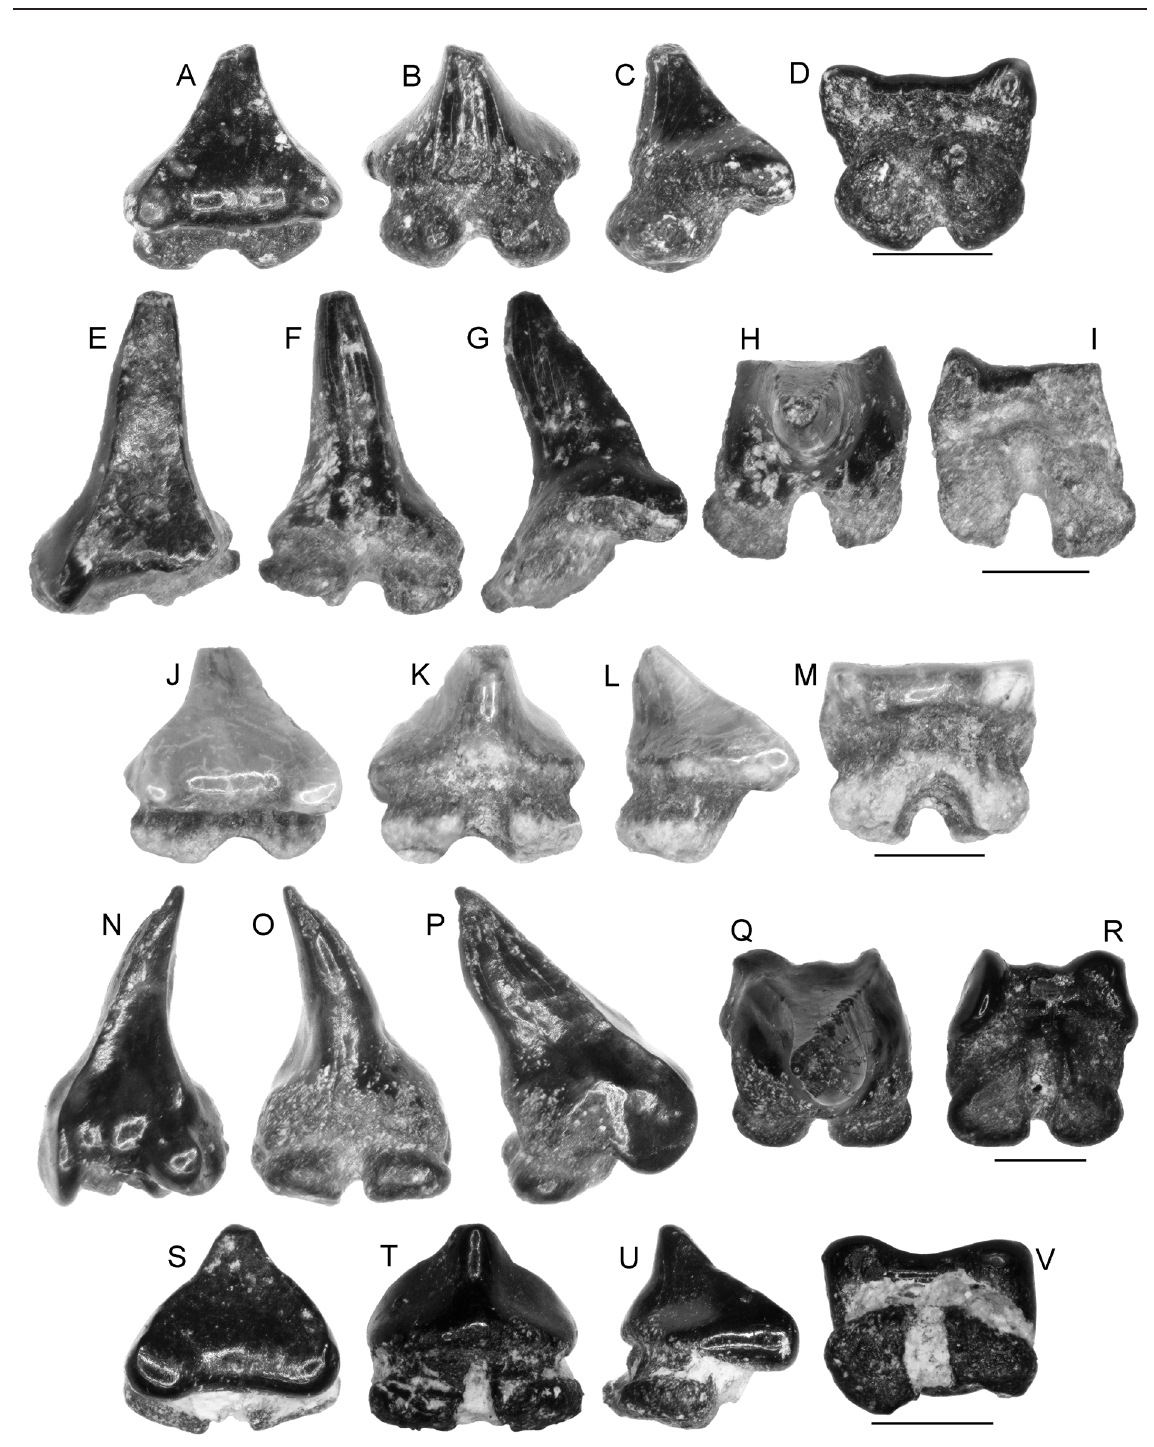
Fig. 43. Jacquhermania duponti (Winkler, 1876), teeth. A–D . SC2012.47.5, basal Lisbon Formation. A . Labial view. B . Lingual view. C . Mesial view. D . Basal view. E–I . MSC 38484, basal Lisbon Formation. E . Labial view. F . Lingual view. G . Mesial view. H . Oral view. I . Basal view. J–M . MSC 37519, Gosport Sand. J . Labial view. K . Lingual view. L . Distal view. M . Basal view. N–R . SC2012.42.4, basal Lisbon Formation. N . Labial view. O . Lingual view. P . Mesial view. Q . Oral view. R . Basal view. S–V . WSU AL15, basal Lisbon Formation. S . Labial view. T . Lingual view. U . Mesial view. V . Basal view. Labial at top in oral and basal views. Scale bars =